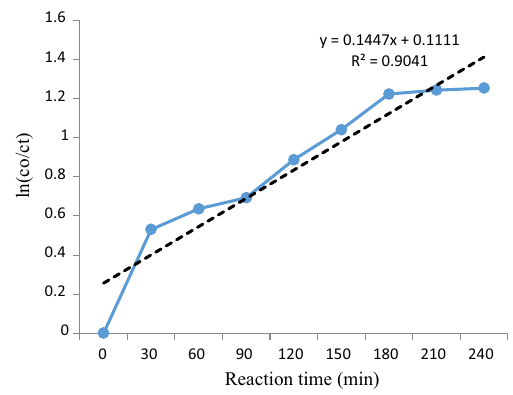
Fig. 5 Kinetics of C.O.D. removal in photo fenton after